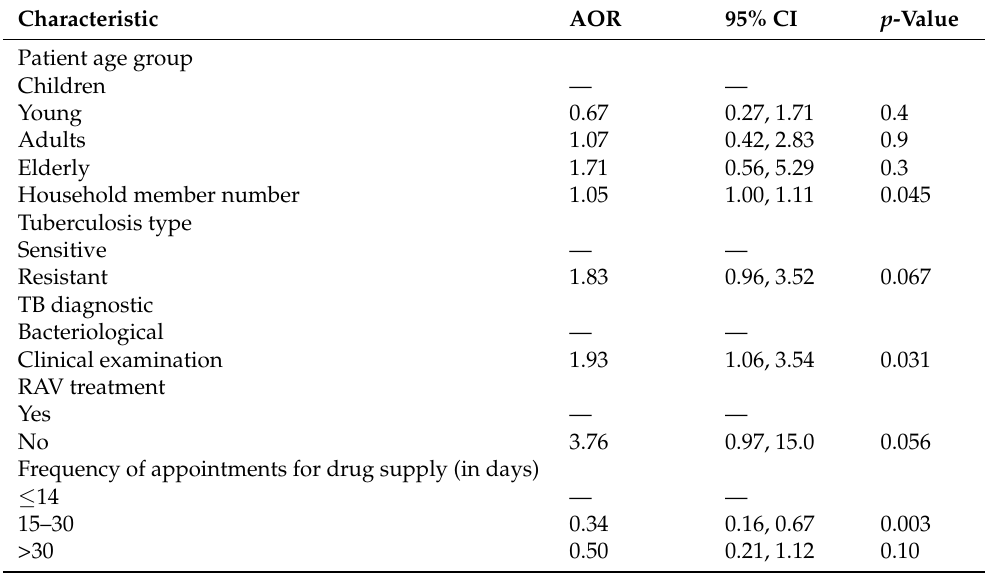
Table 5. Multinomial logistic regression pain/discomfort and sociodemographic and clinical characteristics.